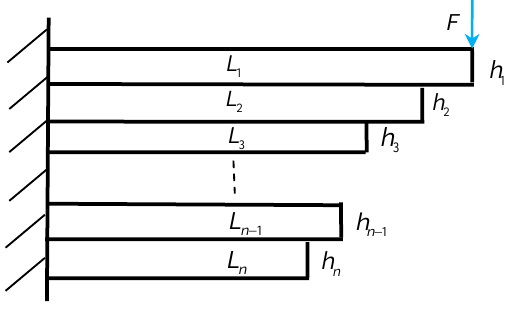
Figure 1. The mechanical model of the multi-leaf spring.